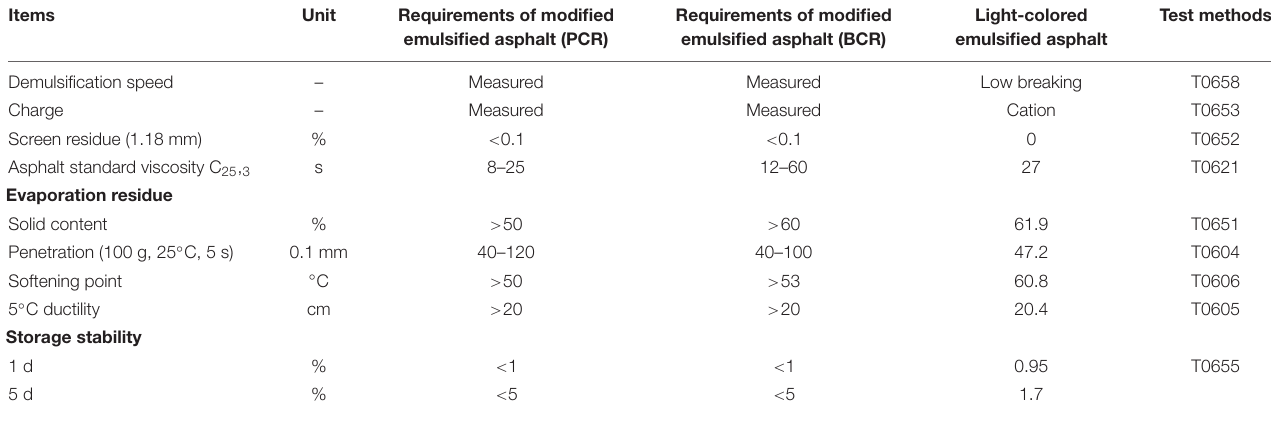
TABLE 1 | Conventional technical indexes of light-colored emulsified asphalt. Items